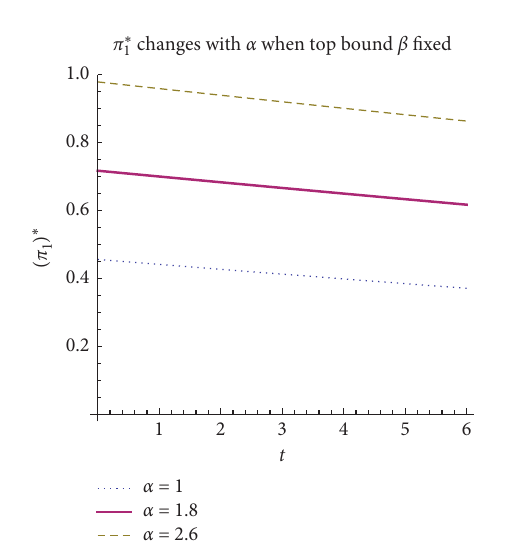
Figure 1: Values of π ∗ change with t for different bottom bound α . 1